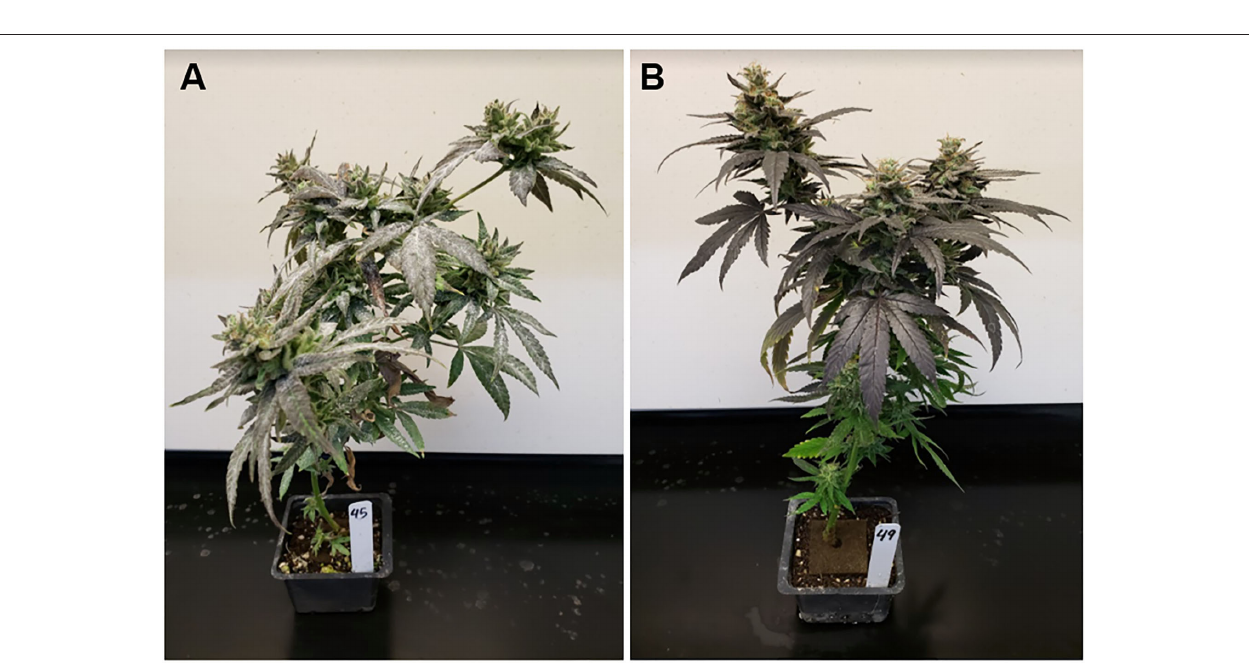
FIGURE 2 | Experiments with heavy disease pressure imposed through plant maturity revealed (A) susceptible phenotypes with dense mycelial growth (pictured: individual #45 from the population “PNW39” × “Jumping Jack”) and (B) resistant phenotypes absent of any powdery mildew colonies (pictured: individual #49 from the population “PNW39” × “Jumping